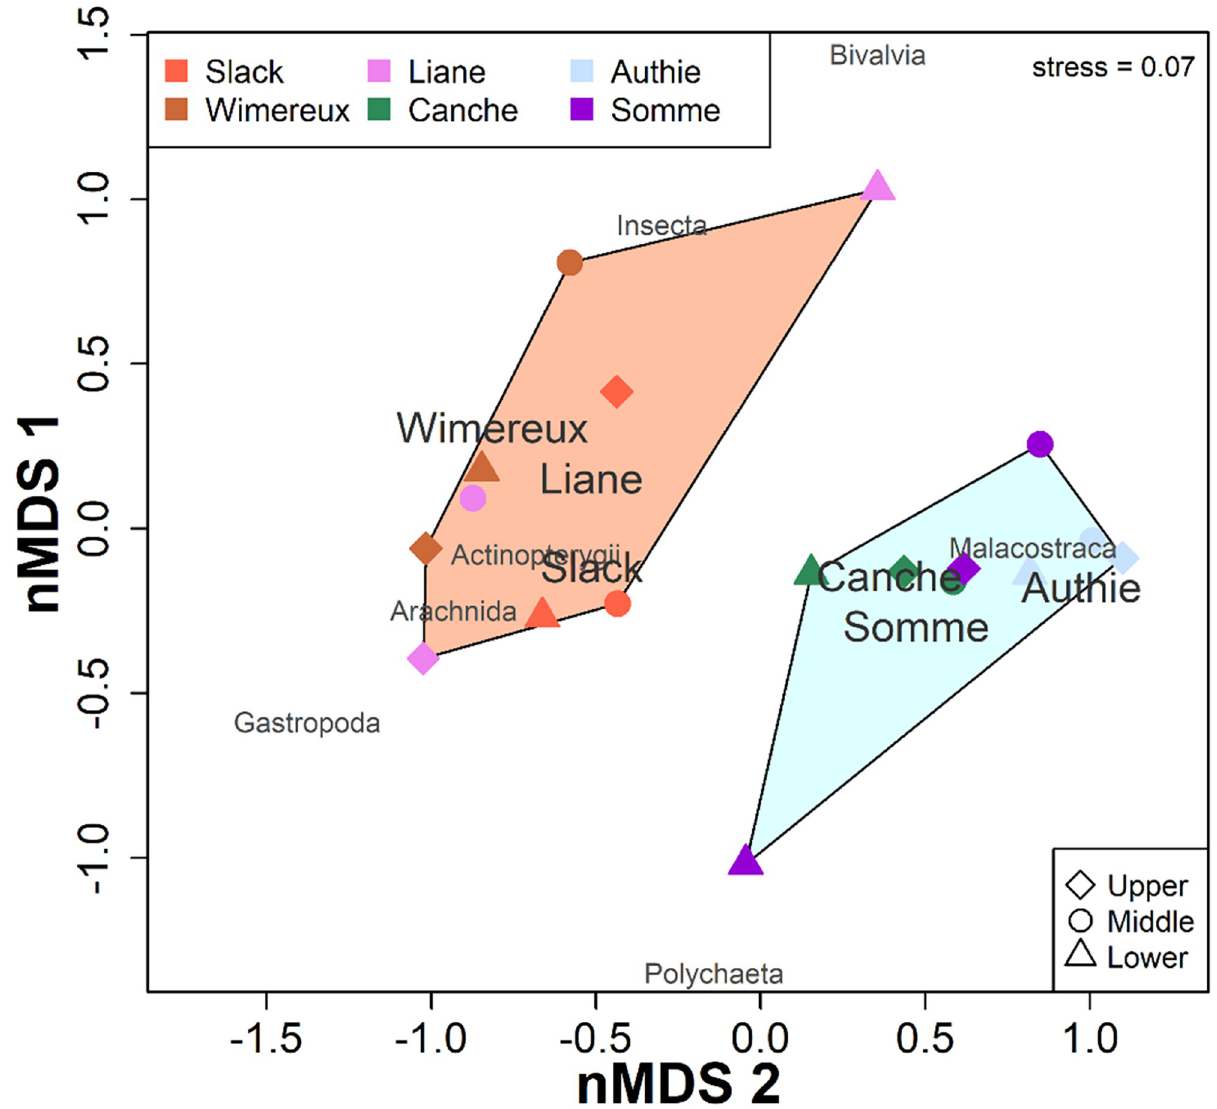
Fig 2. Two-dimensional nMDS ordination performed on the index of relative importance (%IRI) of prey categories in the gut contents of European eels collected along salinity gradient (i.e. lower, middle and upper) in the six estuaries. The ellipses represent the two groups of estuaries identified in the HCA. Stress value is indicated in the top